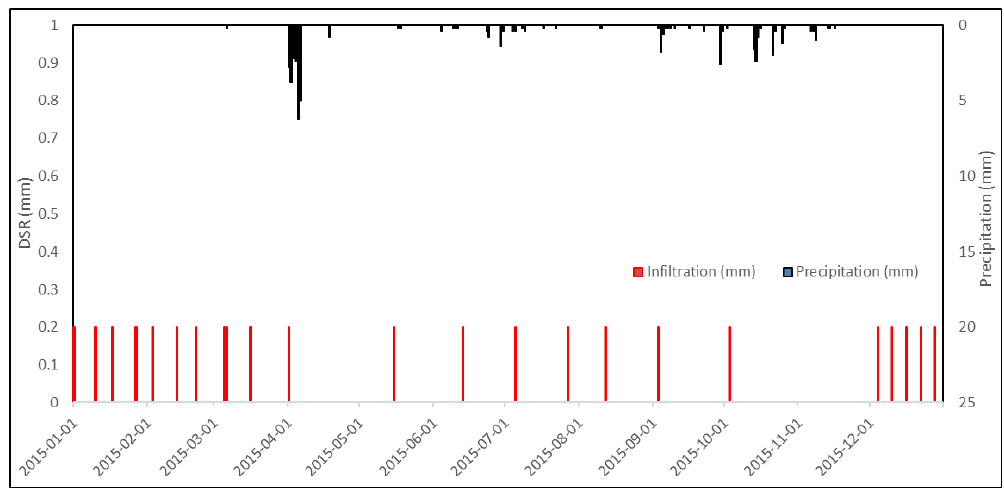
Figure 6. Relationship between precipitation and DSR in 2015 .